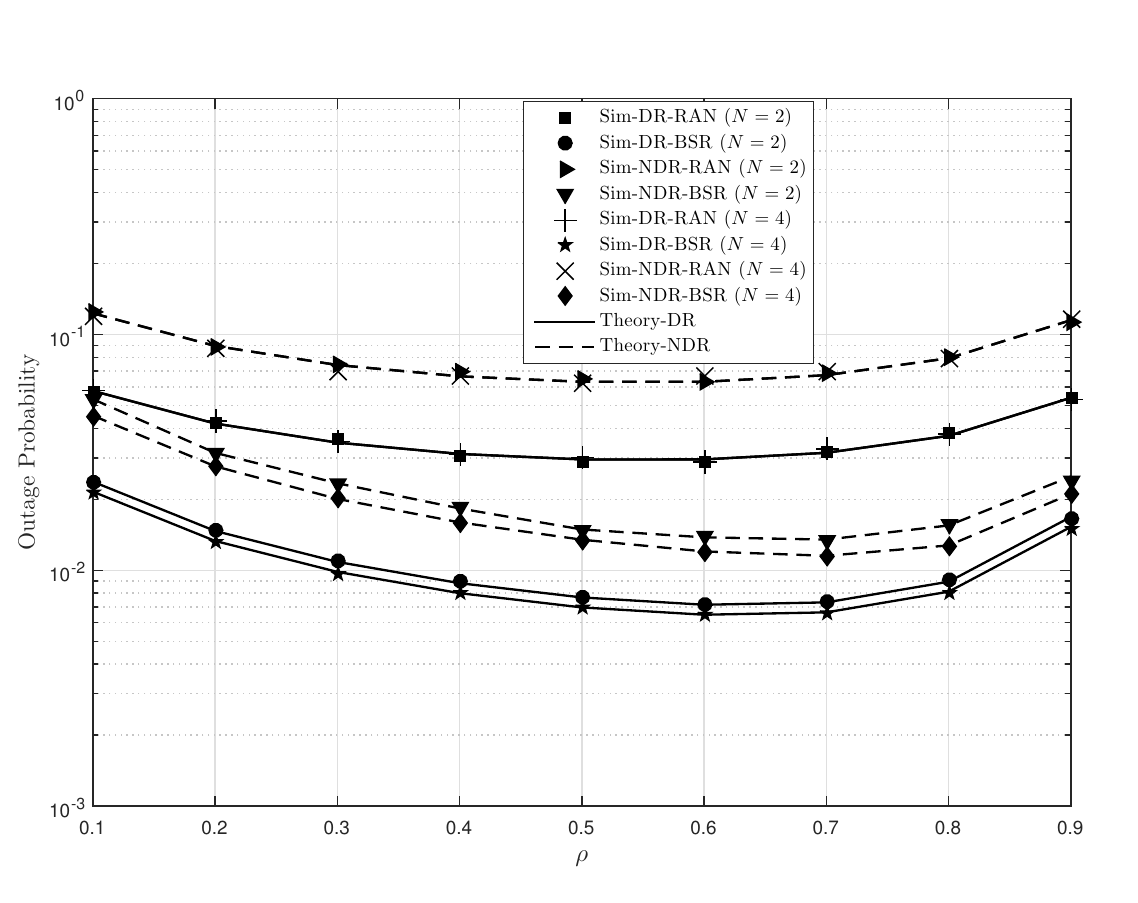
, R 1 , y R 1 ) = (0 . 5 , 0 . 3)